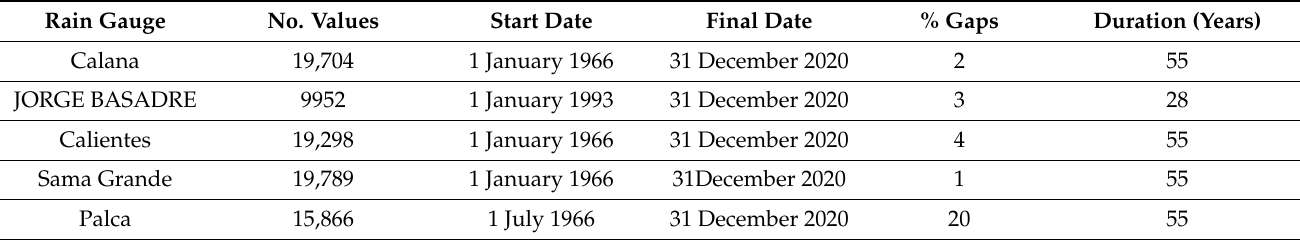
Figure 1. Location of the Devil’s Creek with the meteorological rain gauges selected for the down- scaling and cells of the general circulation models (GCMs). Table 1. Availability of precipitation